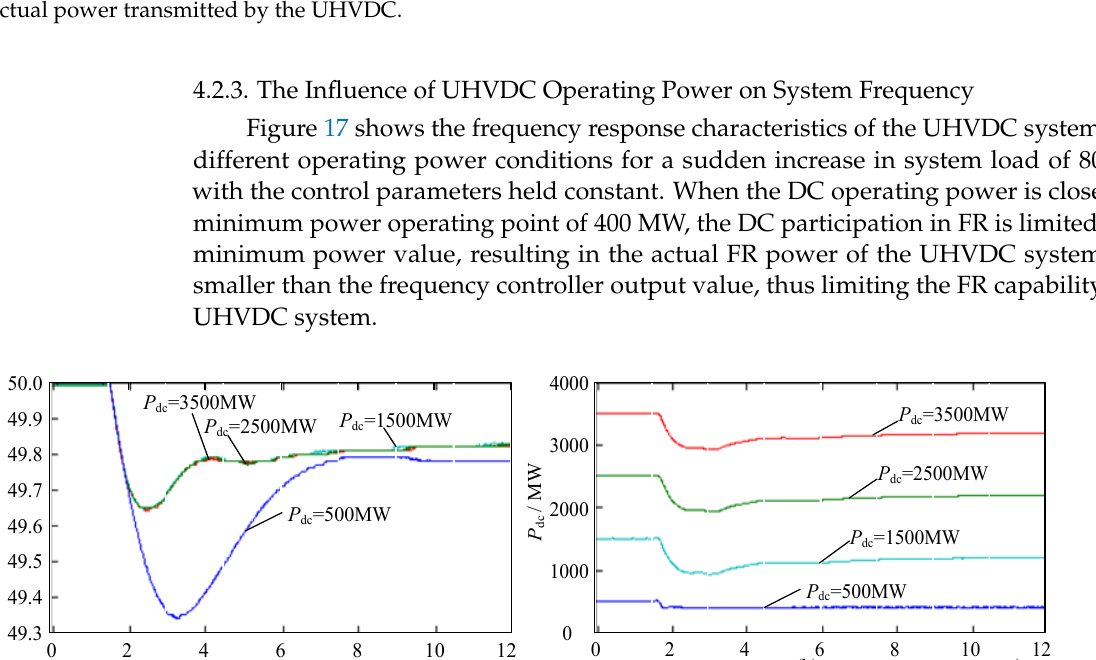
Figure 16. Response characteristics when inertia control dead zone changes. ( a ) The frequencies of the sending-end system; ( b ) the actual power transmitted by the UHVDC.